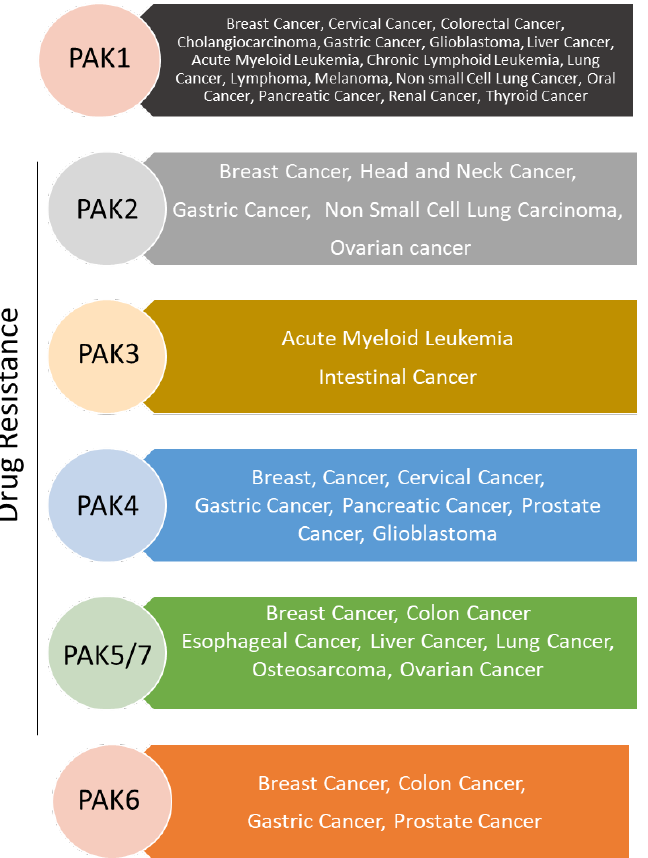
Biomedicines 2023 , 11 , 462 Figure 2. Diagram showing the drug resistance explored in different cancers by PAK.